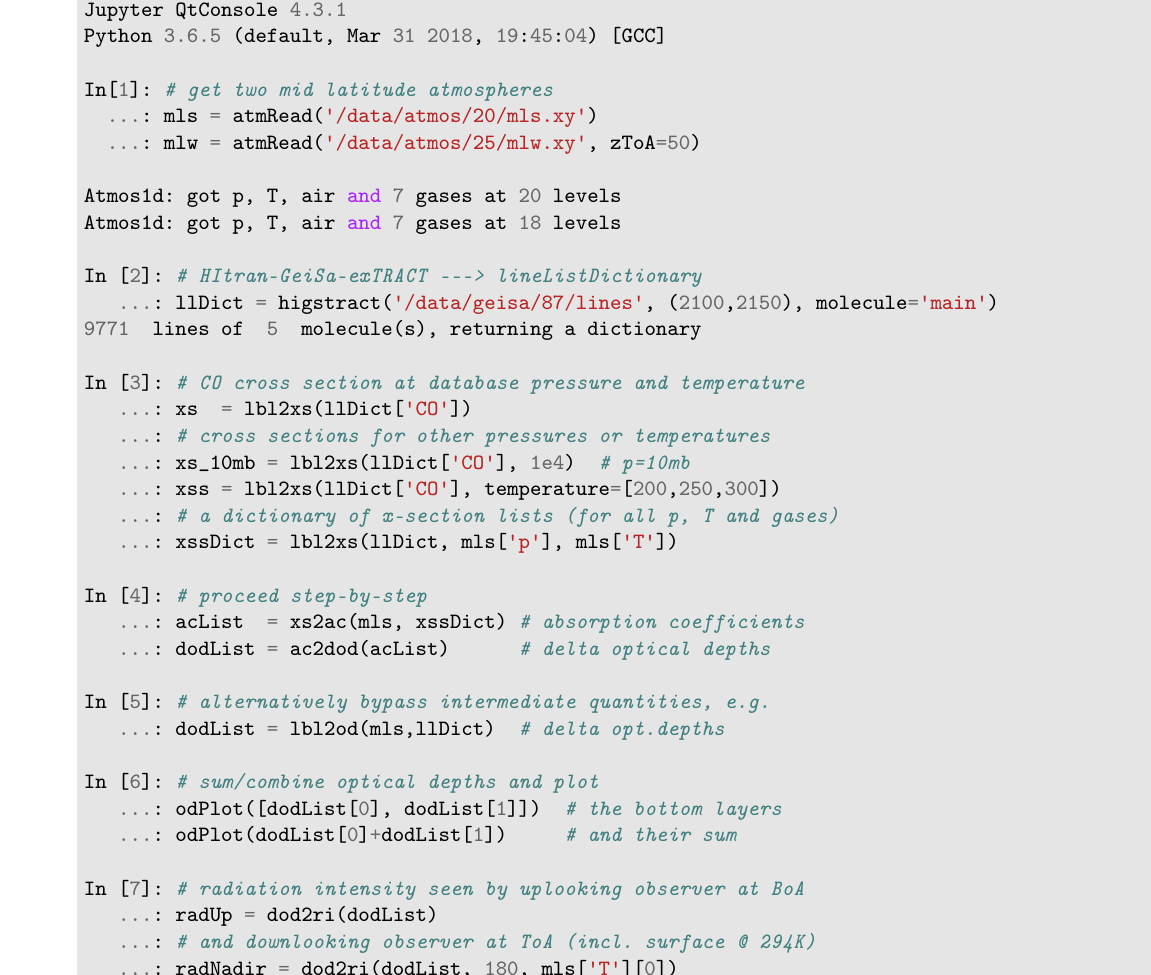
Figure 3. Typical workflow of an IPython session (output not shown except for first two